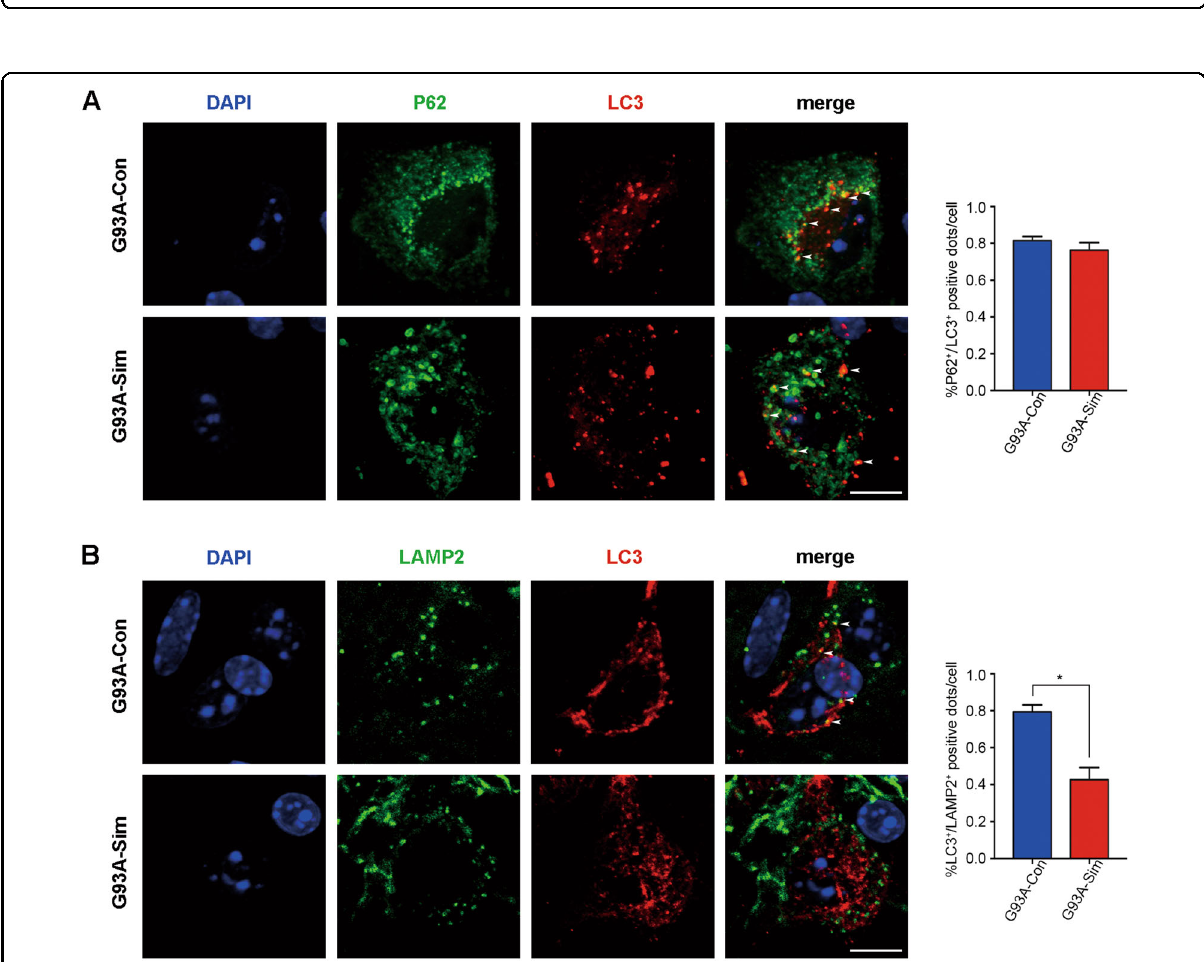
Fig. 4 Simvastatin blocked the maturation of autophagosomes in spinal MNs of SOD1 G93A mice. A Immuno fl uorescence labeling of P62 (green), LC3 (red), and DAPI (blue) in the lumbar spinal cord MNs of G93A-Sim and G93A-Con mice at 120 days, respectively (Scale bars, 10 μ m). White arrowheads show the colocalization of P62 and LC3. Analysis of the ratio of colocalization of P62 and LC3. B Immuno fl uorescence labeling of LAMP2 (green), LC3 (red), and DAPI (blue) in MNs at 120 days (Scale bars, 10 μ m). White arrowheads show the colocalization of LAMP2 and LC3. Analysis of the ratio of colocalization of LAMP2 and LC3. (Data represent the mean ± SEM, n = 5 mice per group; statistical signi fi cance was assessed by an unpaired t -test, * P ≤